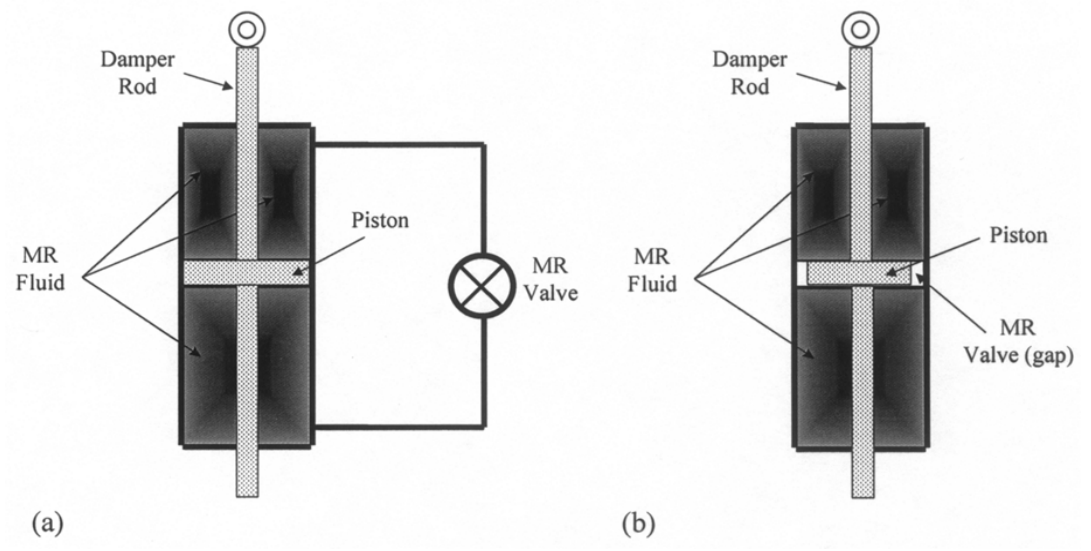
Fig. 1. Functional representation of an MR damper; (a) MR damper with external valve; (b) MR damper with internal